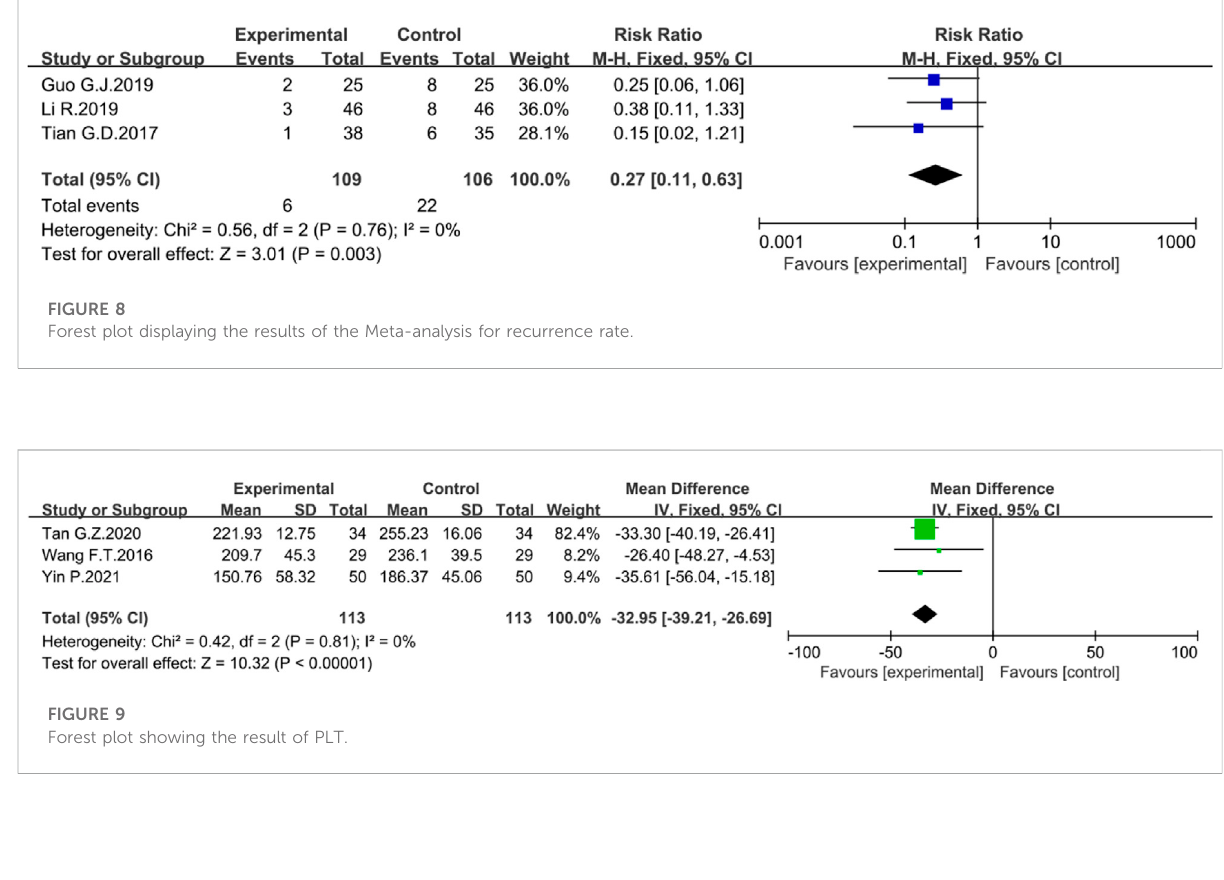
FIGURE 7 Forest plot showing the result of (A) Mayo score; (B) Geboes score.